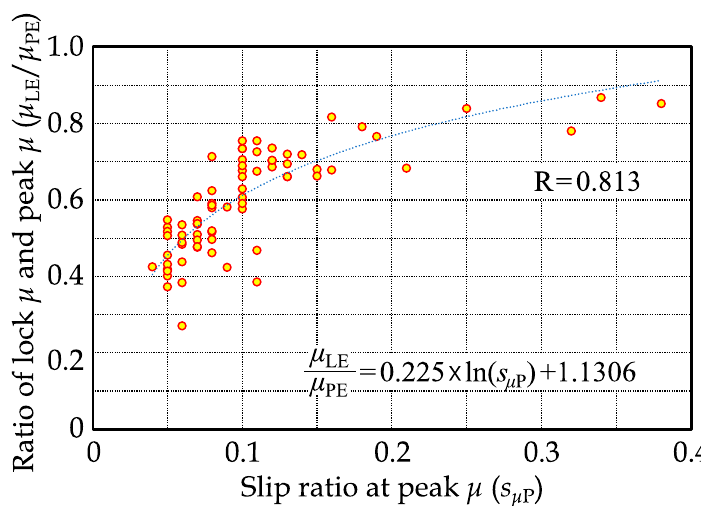
Figure 5. Relationship between the slip ratio and the ratio of lock μ by peak μ .